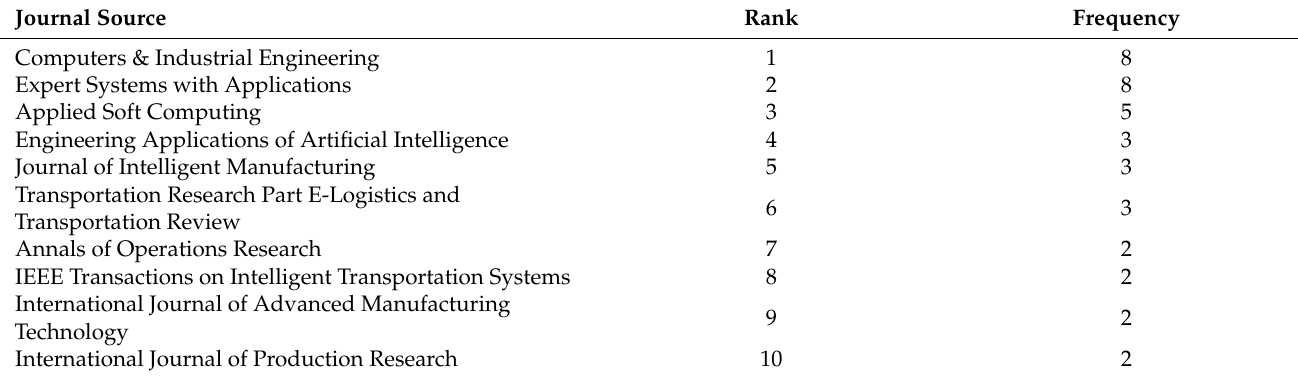
Table 5. The top 10 most relevant journals to PSO/VRP found in the Web of Science search using Bradford’s